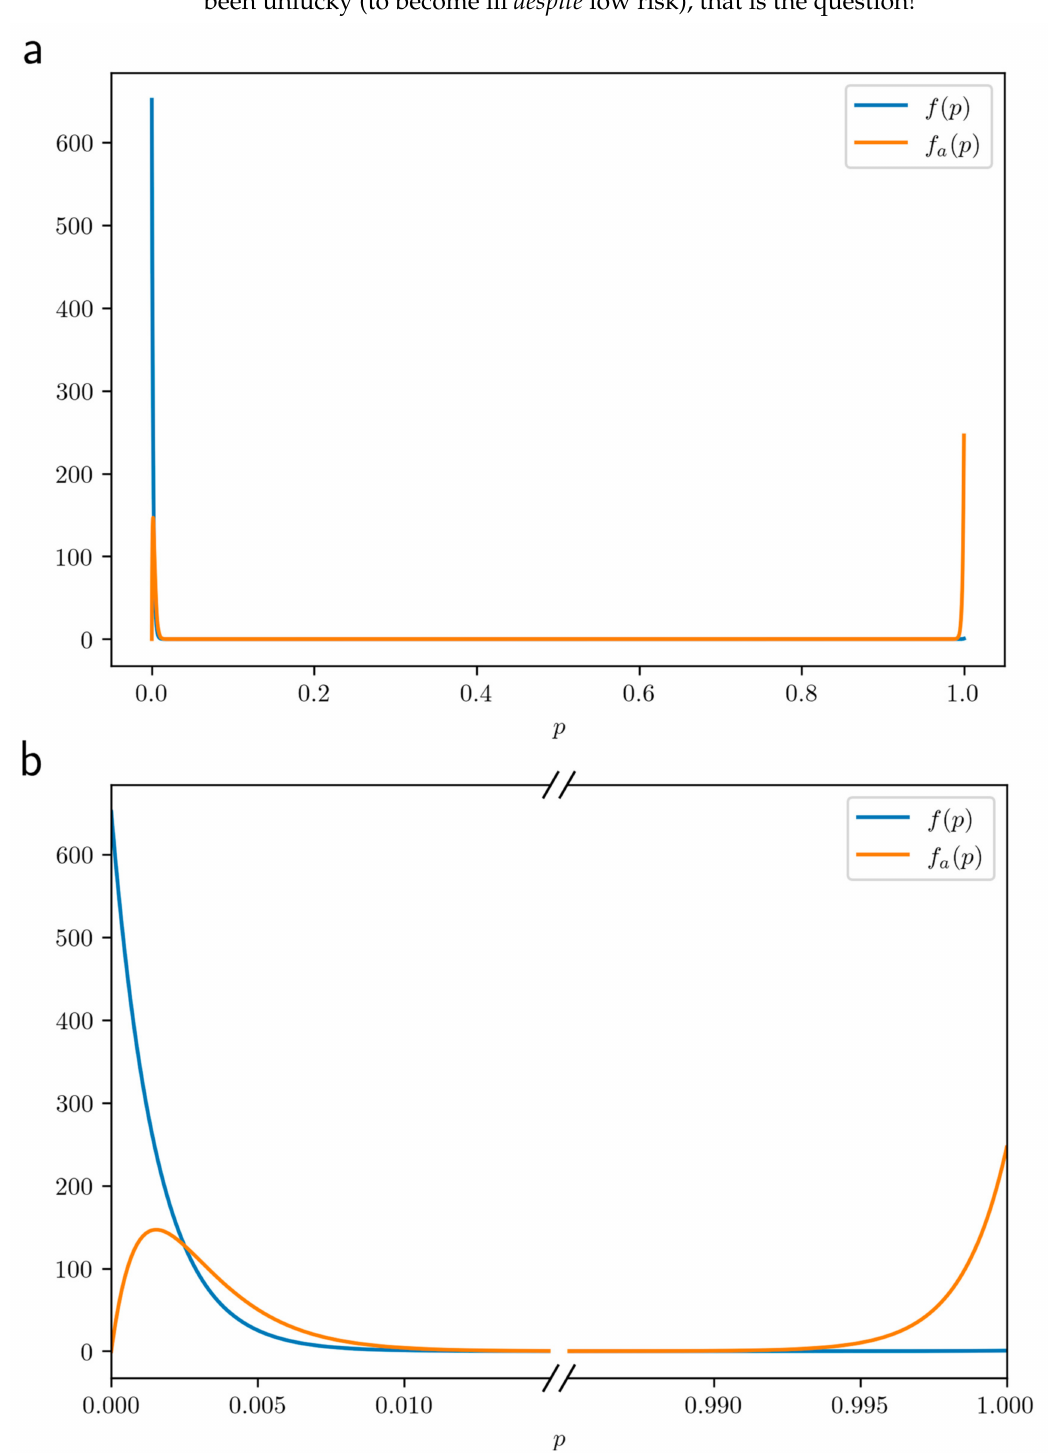
Figure 4. ( a ) CD risk distribution function f ( p ; m , s ) among the population (in blue) is narrow peaked at p = 0. The risk distribution function f a = pf ( p ; m , s ) Φ among affected people (in orange) has two narrow peaks. ( b ) Zoom in the vicinity of both peaks p = 0 and p = 1. Concordant twins (almost) all belong to the right peak (at p = 1) whereas discordant twins (almost) all belong to the left peak (at p =